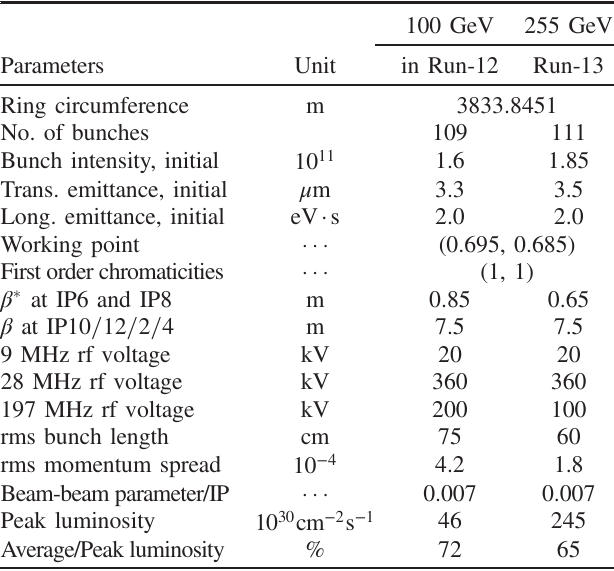
TABLE I. Beam and optics parameters for the 2012 100 GeV and 2013 255 GeV RHIC polarized proton runs.